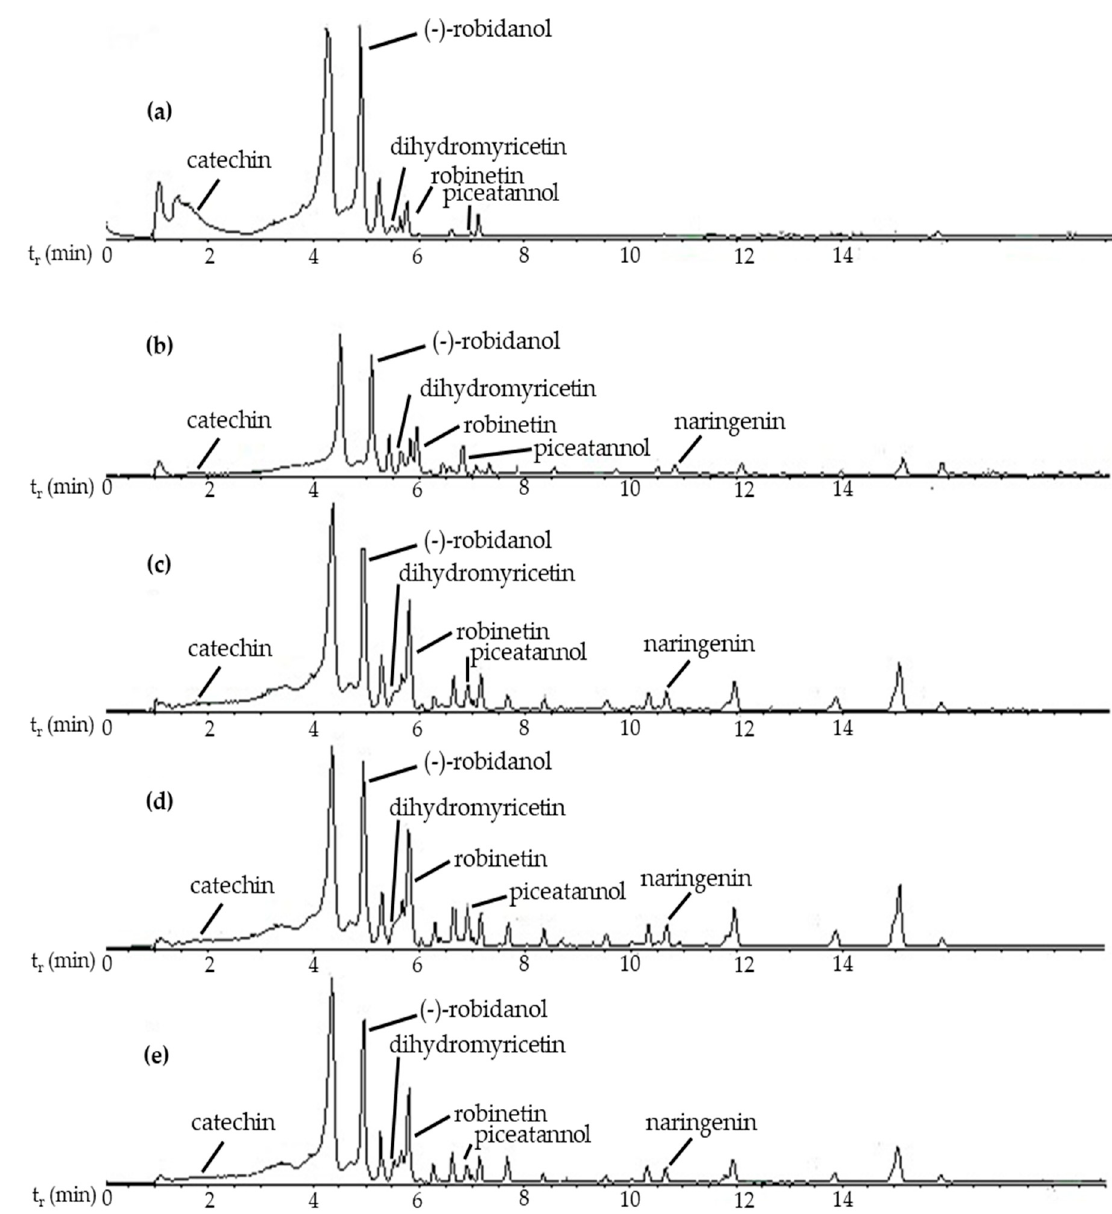
Figure 1. Chromatogram profile of five I. bijuga extracts. ( a ) E0, ( b ) E25, ( c ) E50, ( d ) E75, and ( e ) E100. 3.2. Yield, Bioactivity, and Phytochemical Profile of Phytosome